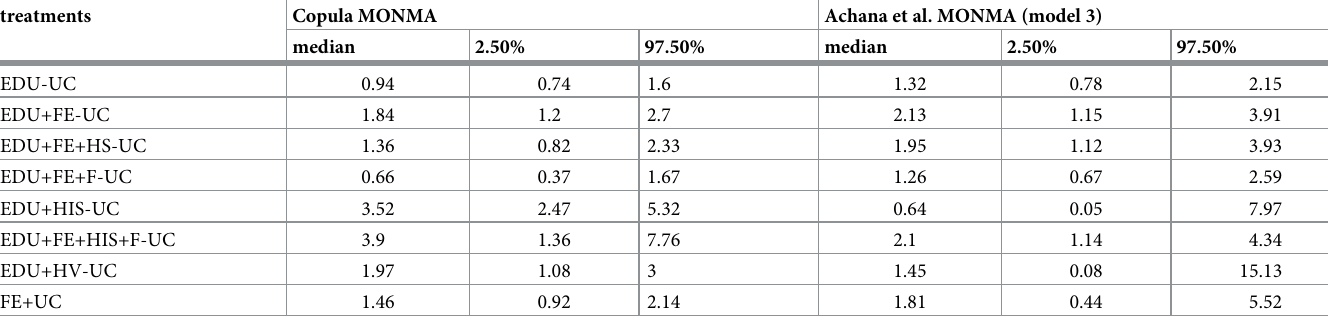
Tables 1 to 3 display median estimates along with the highest posterior density (HPD) cred- ibility intervals for the pooled effects estimated according to our model and according to [51], referred to as Model 3 in the original paper. Usual care is taken as baseline effect. In all cases our estimates show a smaller variability, in particular in the estimation of the pooled effect of Education + Home Visit versus Usual Care, of Education + Home Safety Inspection versus Usual Care and of Provision of Free/Low Cost Equipment versus Usual Care. The EDU+HV and EDU+HSI are indeed considered only for one outcome and the effect directly compared against Usual Care. The FE treatment is considered for two outcomes and only indirectly com- pared against Usual Care. The smaller uncertainty of the median estimates for such treatments Table 3. Poison control center telephone number possession: Pooled effects median and HPD 95% credibility intervals. treatments